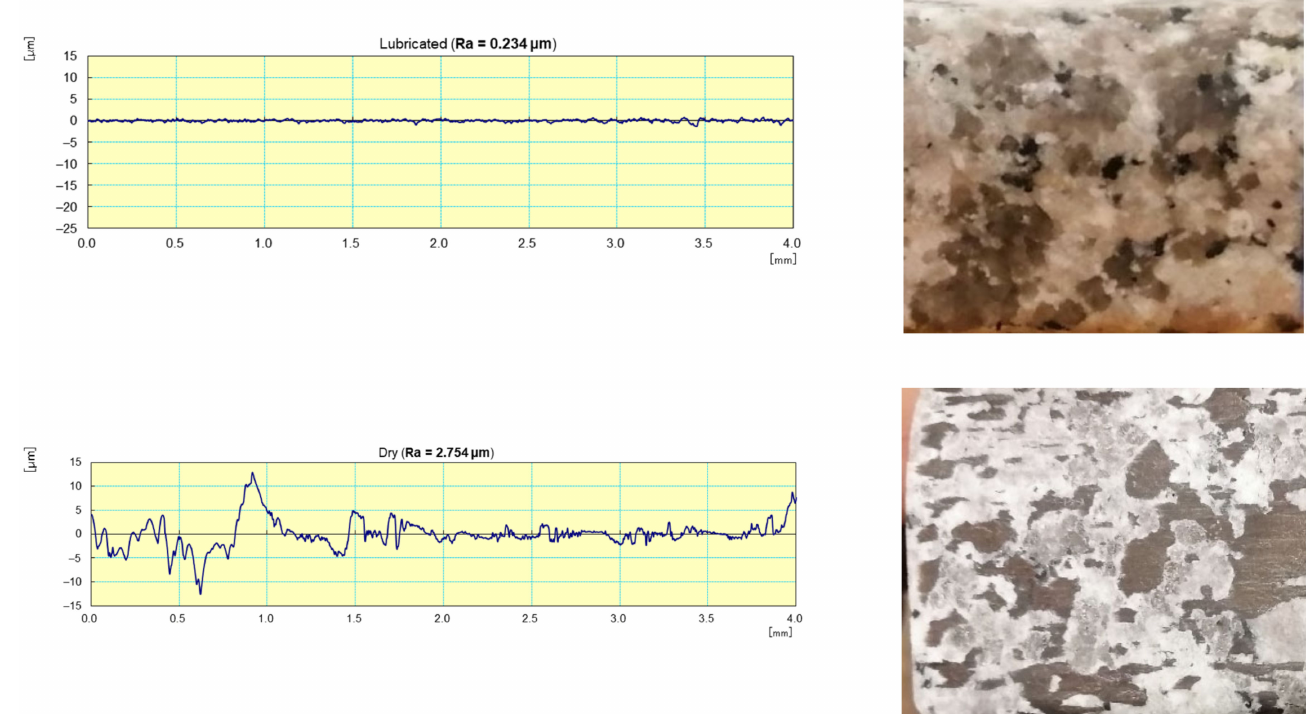
Figure 24. Profile surface and finish of a polished white granite edge (Vs = 3500 rpm; f = 1000 mm/min; grit